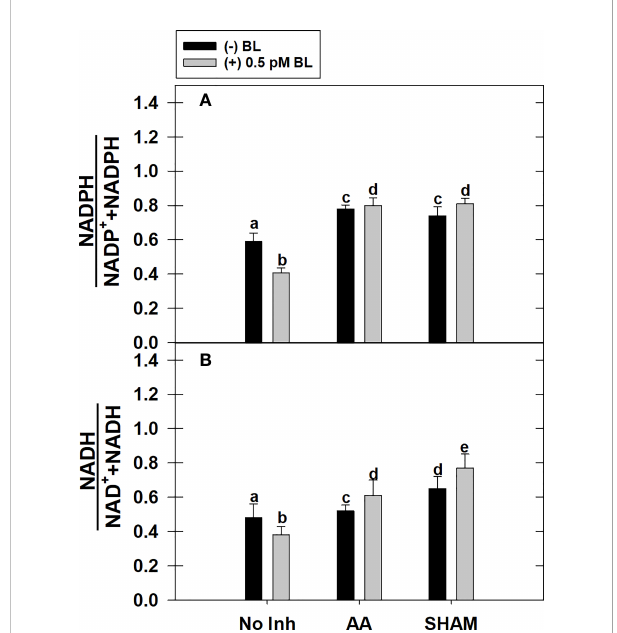
FIGURE 6 Effect of BL on the total cellular level of redox ratio related to NADP (H) (A) and NAD(H) (B) under the disruption of COX pathway or AOX pathway in MCP of A . thaliana . The MCP in the reaction medium was pre-incubated with or without 0.5 pM BL in the presence or absence of 100nM AA (COX pathway Inhibitor) or 0.5 mM SHAM (AOX pathway inhibitor) for 10 min at a light intensity of 1000 m mol m -2 s -1 at 25°C. After treatment, MCP was immediately stored in liquid N 2 for analysis. Further, the section “ materials and methods ” mentions more detailed information on the procedure. No Inhibitor (No Inh) depicts a sample without mETC inhibitors. A statistically signi fi cant difference is represented by different lowercase alphabetical letters (P ≤ 0.05) and values represent the average (± SE) of three